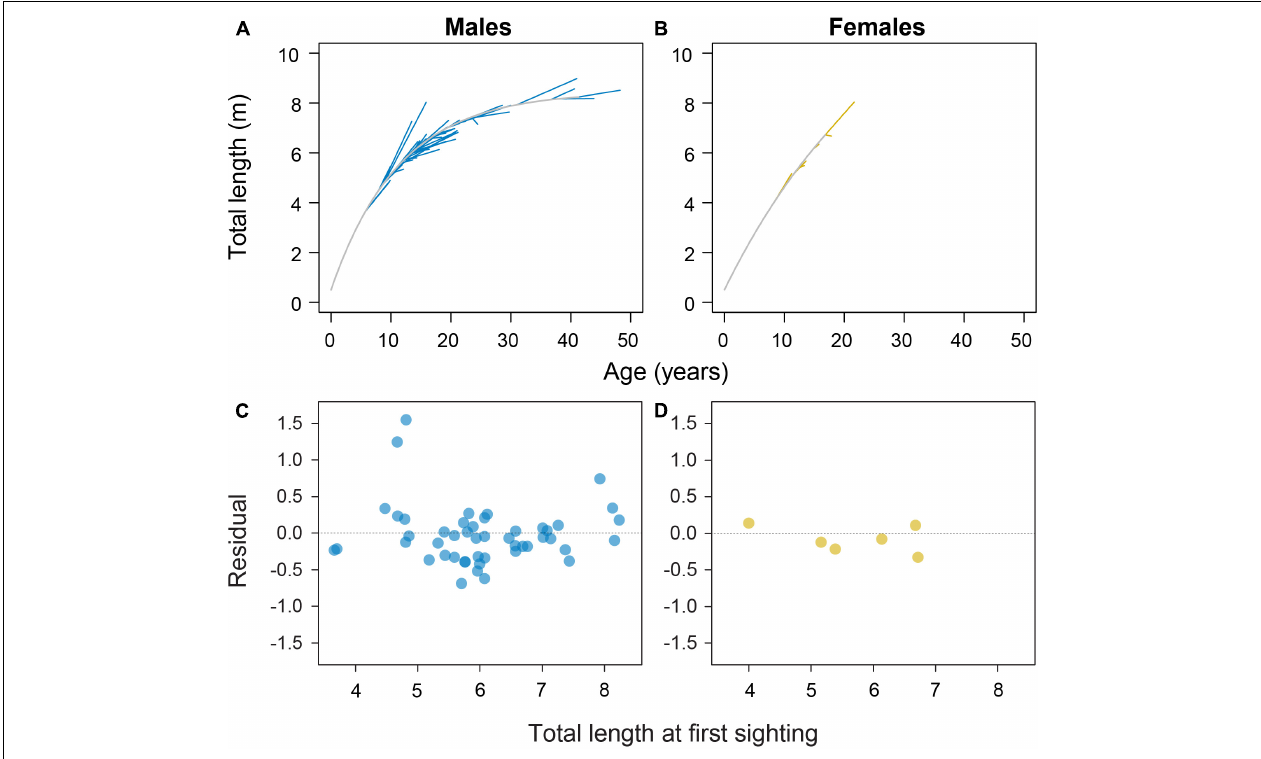
FIGURE 2 | Sex-specific growth profiles (in gray) with individual shark growth trajectories plotted in blue for 48 male (A) and yellow for 6 female whale sharks (B) with associated residual plots (C,D) from the von Bertalanffy growth model fitted to whale shark resighting data.